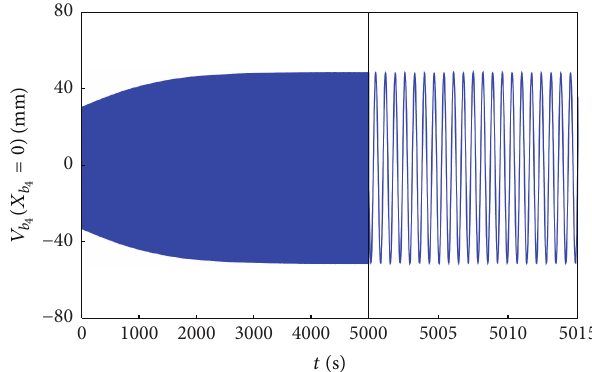
Figure 6: Time response of the midpoint of the deck beam, 𝑞 𝑟 (0) = 0.1𝛿 7𝑟